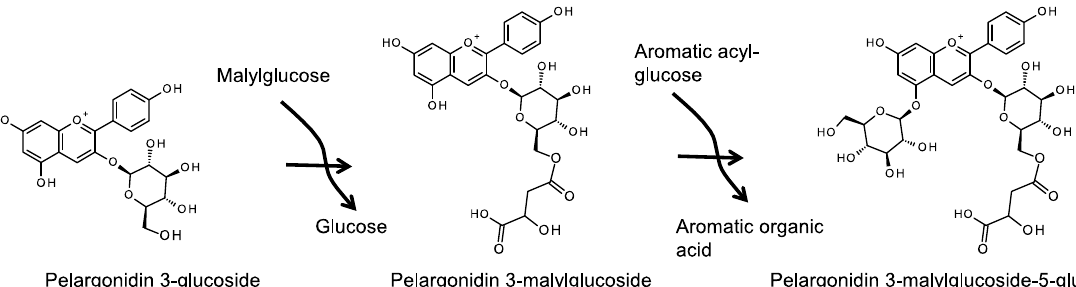
Figure 6. Anthocyanin malylation and glucosylation catalyzed by acyl-glucose dependent transferases in